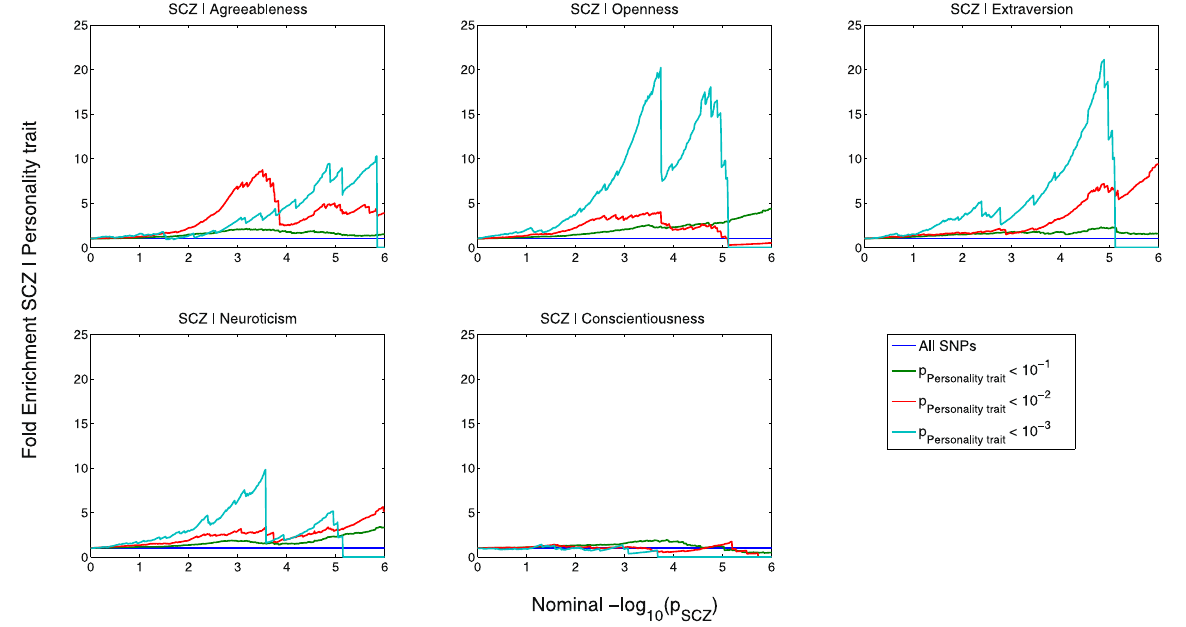
Figure 2. Fold-enrichment plots of enrichment versus nominal − log 10 p-values (corrected for inflation) in schizophrenia (SCZ) below the standard GWAS threshold of p < 5 × 10 − 8 as a function of significance of association with agreeableness, openness, extraversion, neuroticism and conscientiousness at the level of − log 10 (p) ≥ 1, − log 10 (p) ≥ 2, − log 10 (p) ≥ 3 corresponding to p ≤ 0.1, p ≤ 0.01, p ≤ 0.001, respectively. Blue line indicates all SNPs.